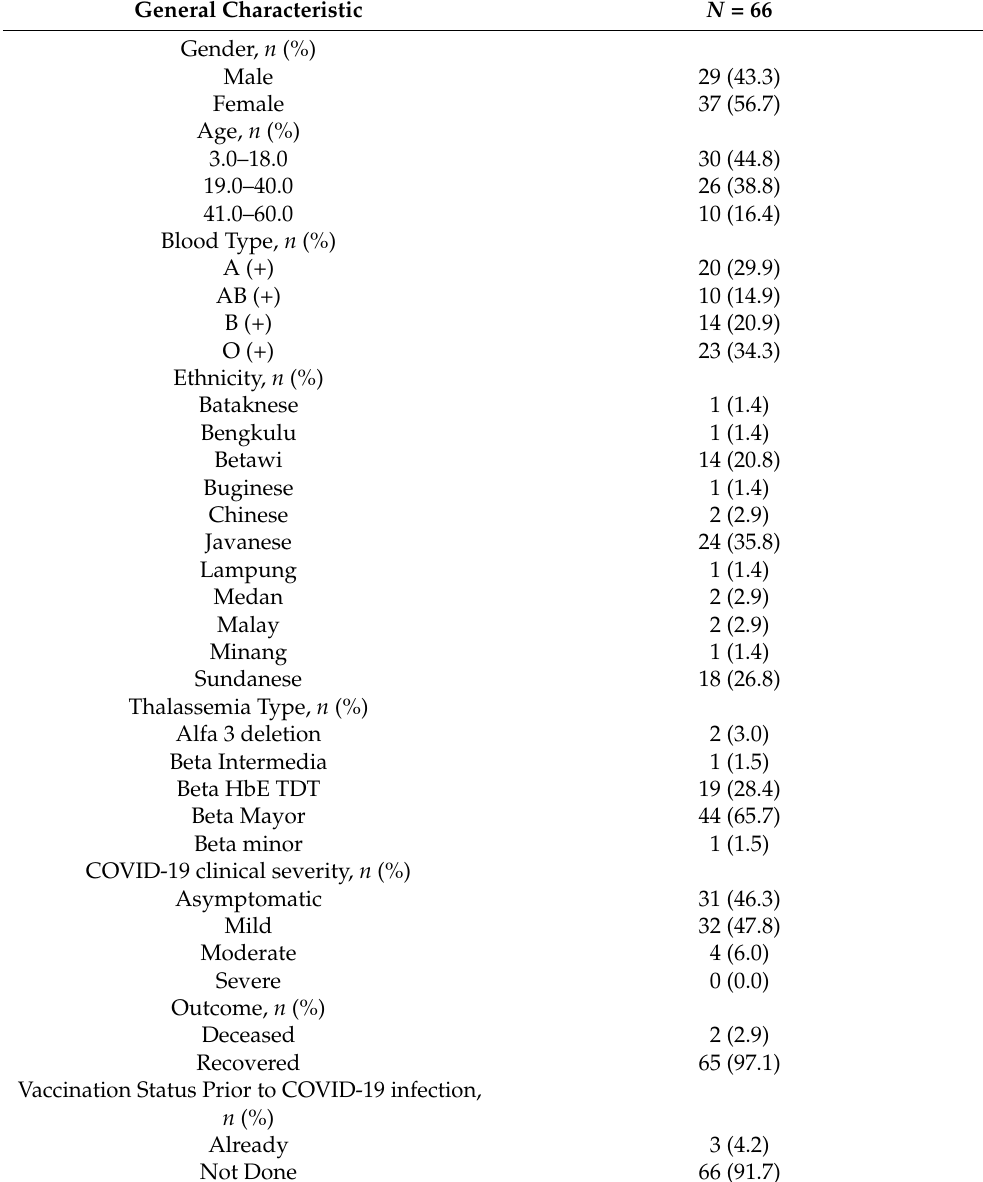
Table 1. Characteristics Thalassemia patients infected by COVID-19 in